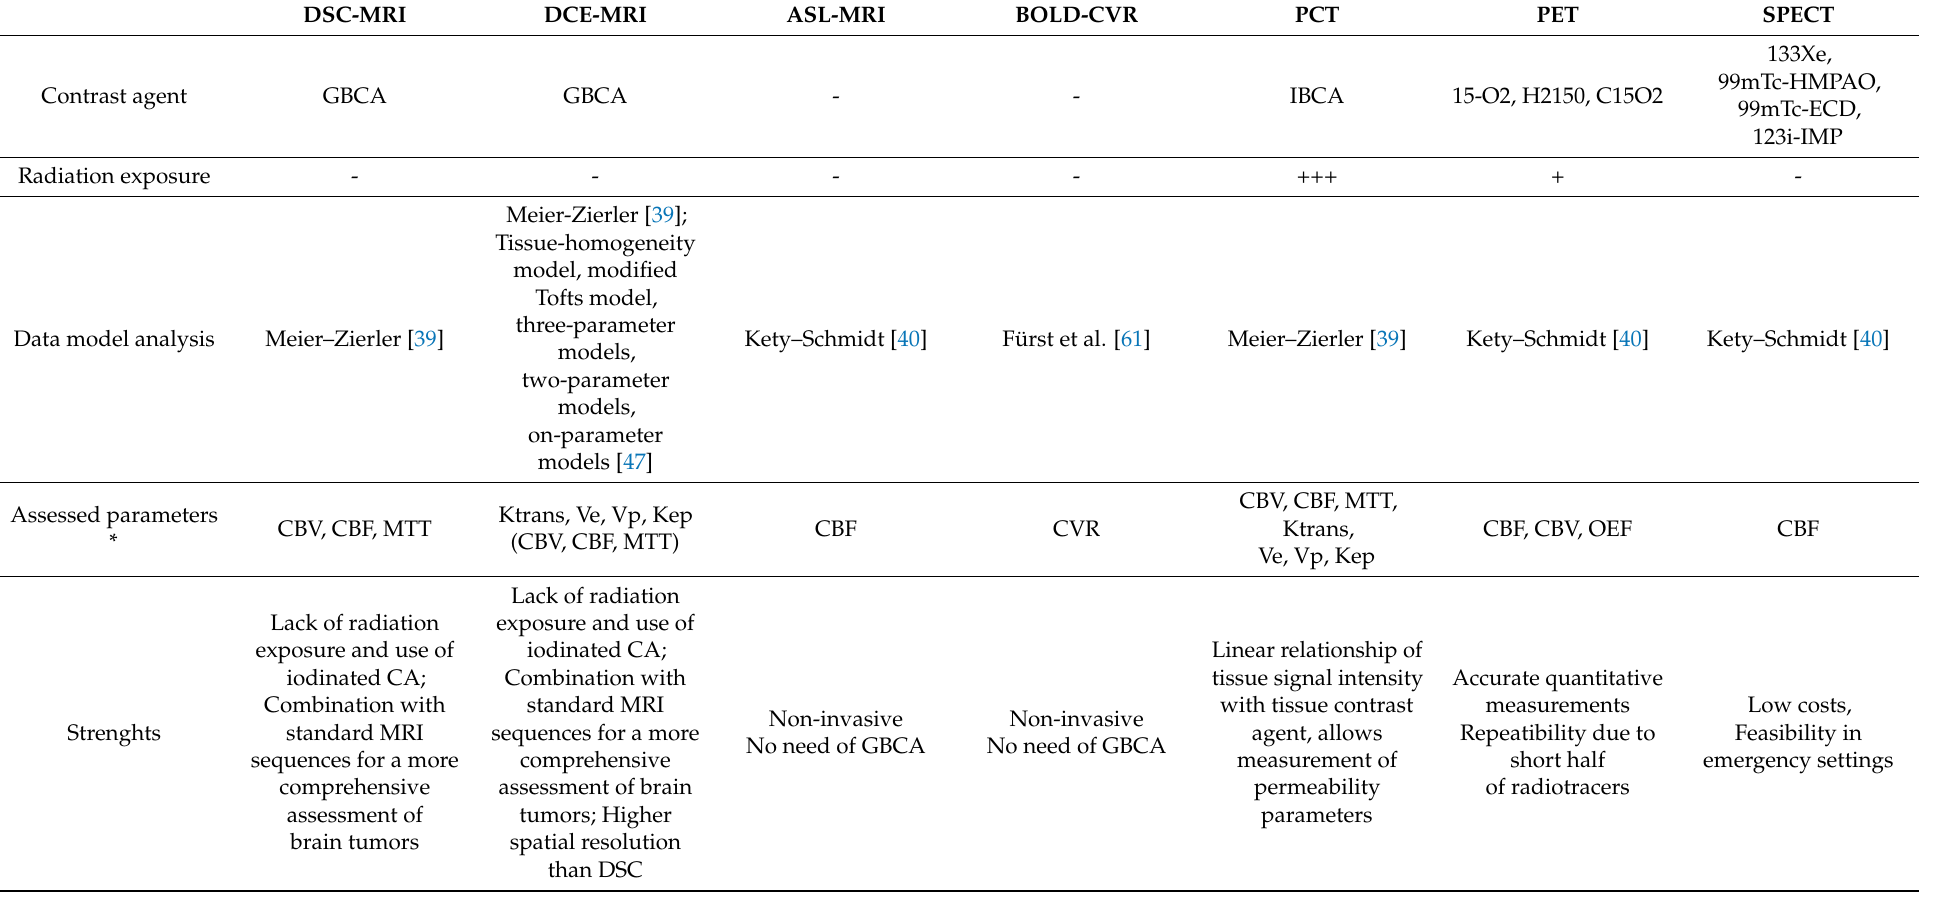
Table 1. Overview of hemodynamic imaging techniques. Abbreviations: AIF, arterial input function; ASL, arterial spin labeling; BBB, blood–brain barrier; BOLD, blood-oxygen-level-dependent; CA, contrast agent; CVR, cerebrovascular reactivity; DSC, dynamic susceptibility contrast; DCE, dynamic contrast-enhanced; GBCA, gadolinium-based contrast agent; IBCA, iodine-based contrast; MTT, mean transit time; PCT, perfusion computed tomography; PET, positron emission tomography; SPECT, single-photon emission computed